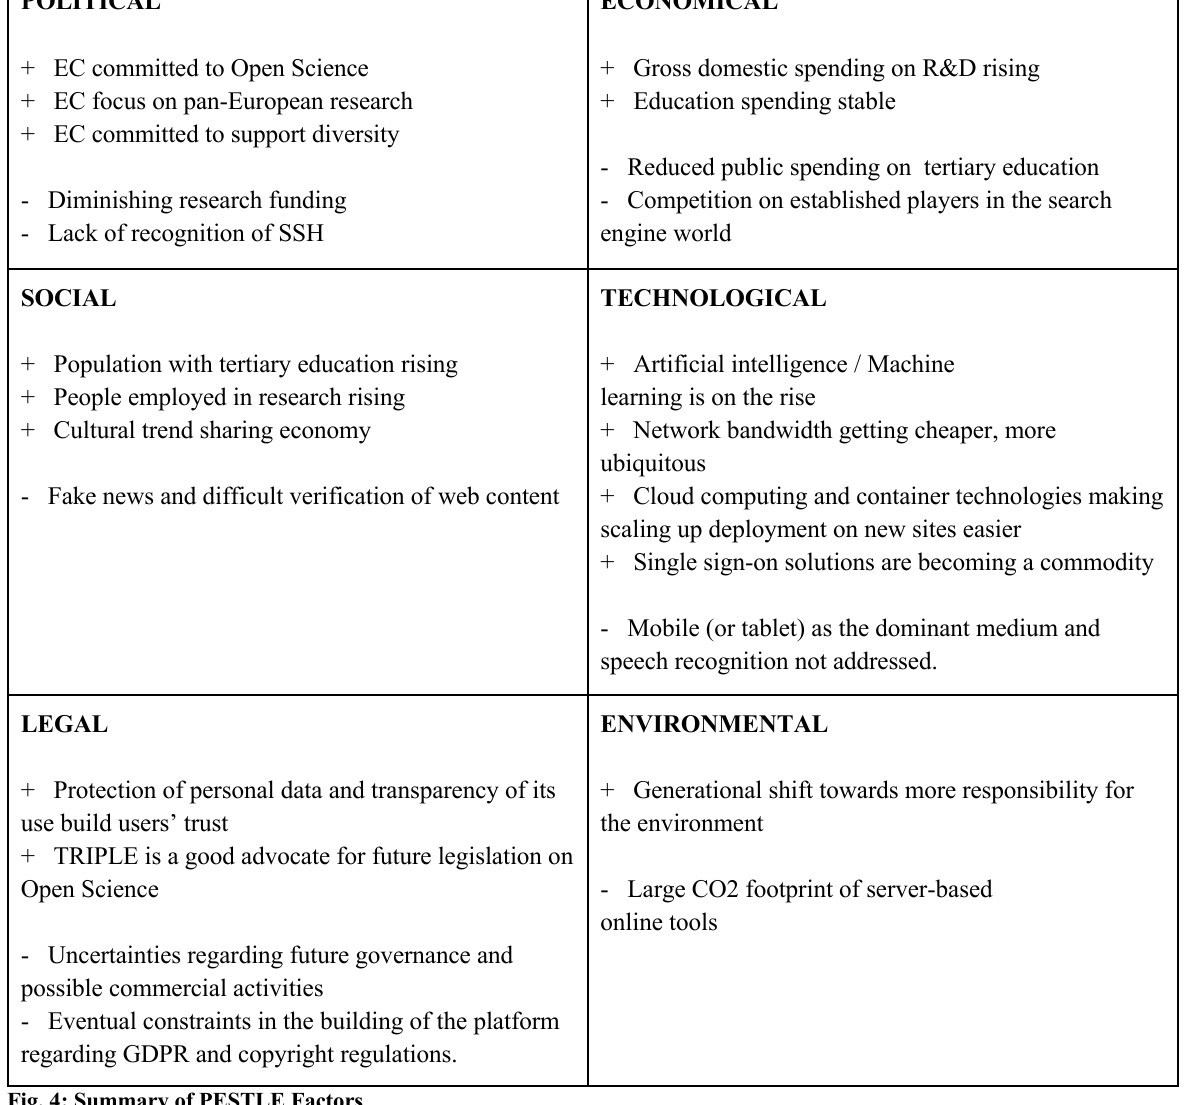
Fig. 4: Summary of PESTLE